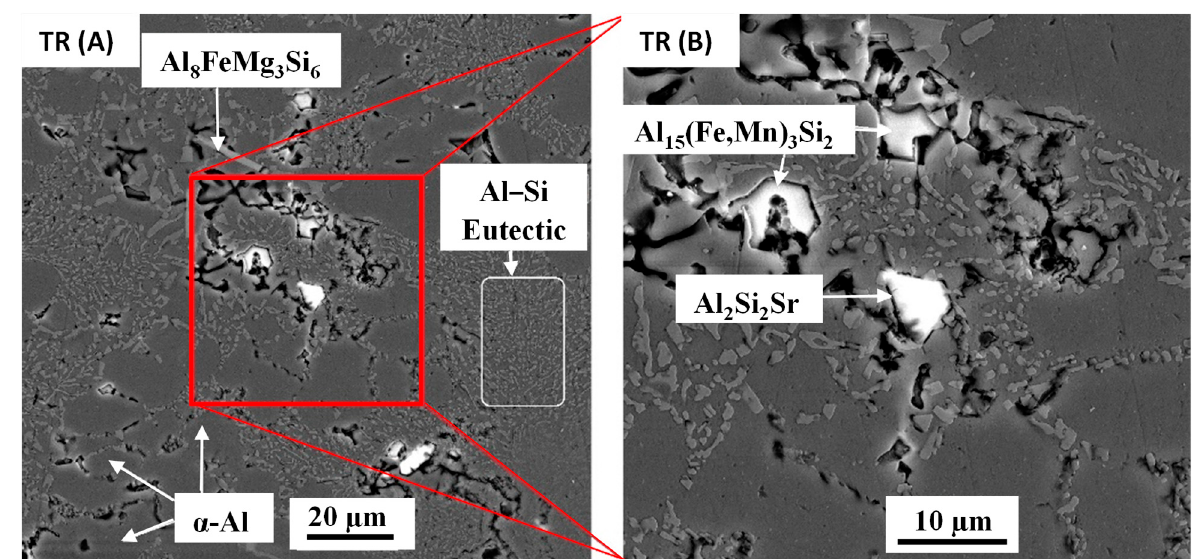
Figure 7. Micrograph showing the TH specimen: ( A ) representative primary phases; ( B ) close-up of the red box region in ( A ).